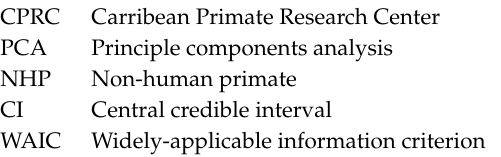
Figure S1: Distribution of behavior amounts across focal observations. Figure S2: Choosing number of states for the Cayo Santiago data using WAIC. Figure S3: Choosing number of states for simulated data using WAIC. Table S1: Factor loadings for factor model 1. Table S2: Factor loadings for factor model